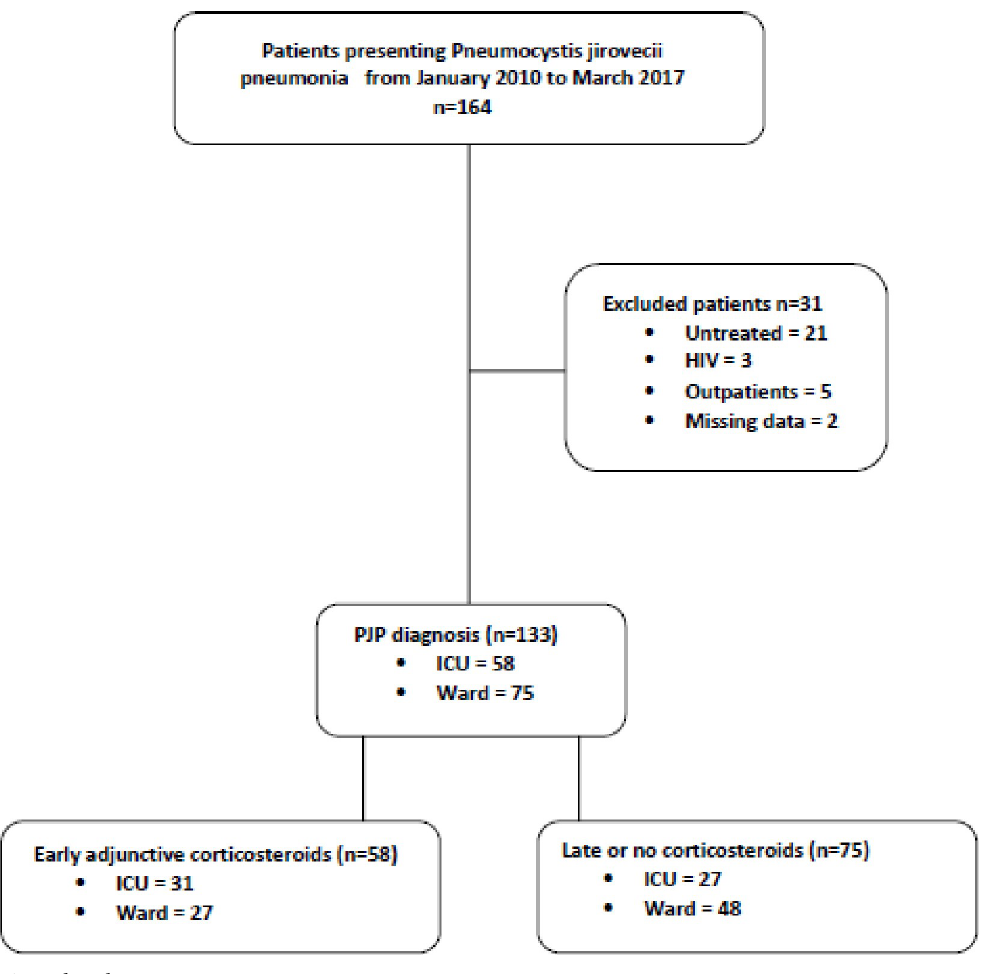
Fig 1. Flow chart.